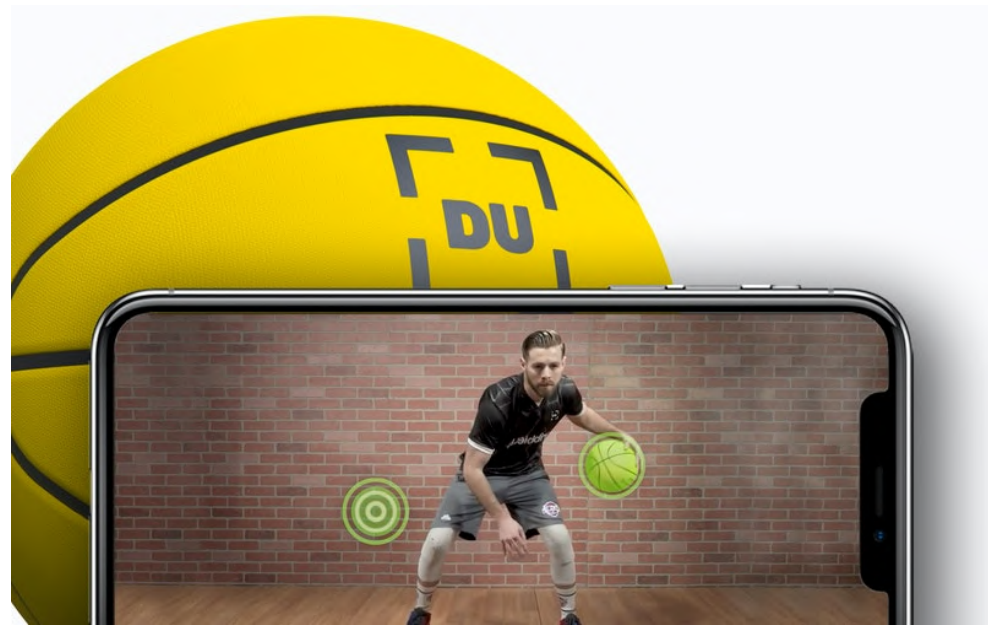
Figure 3: DribbleUp: Smart Basketball